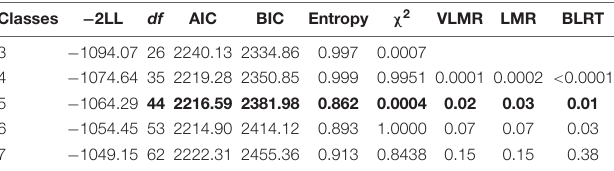
TABLE 4 | Model fit indices for